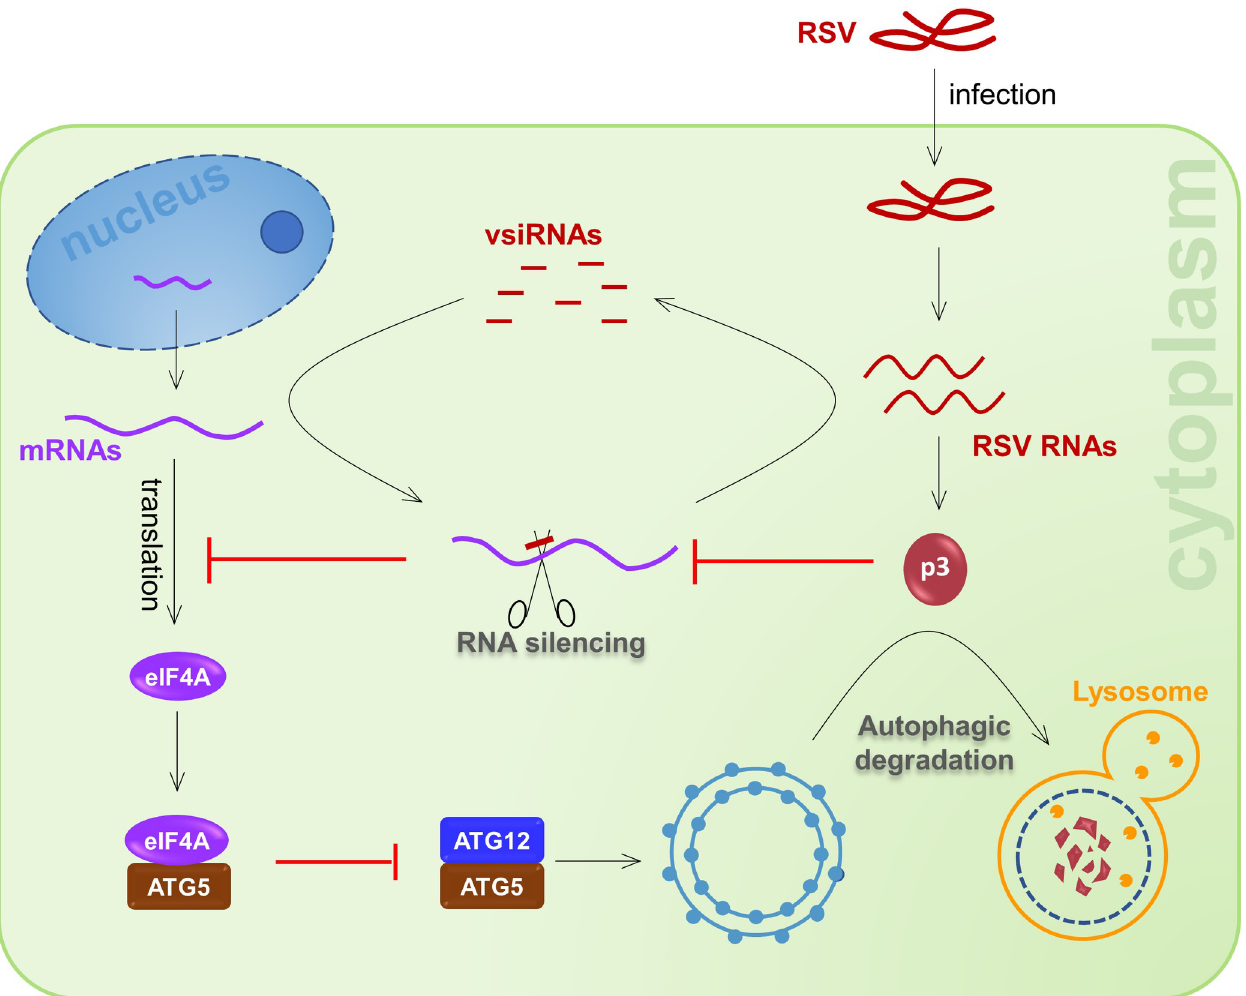
Fig 8. Proposed model for the induction of autophagy and its antiviral roles in RSV infection. In plants, eIF4A functions as a negative regulator that suppresses autophagy by interacting with ATG5. Upon RSV infection, eIF4A mRNA is targeted by vsiRNAs for cleavage. The resulting downregulation of eIF4A releases ATG5 to activate autophagy, which inhibits RSV infection by degrading p3 protein, a suppressor of antiviral RNA